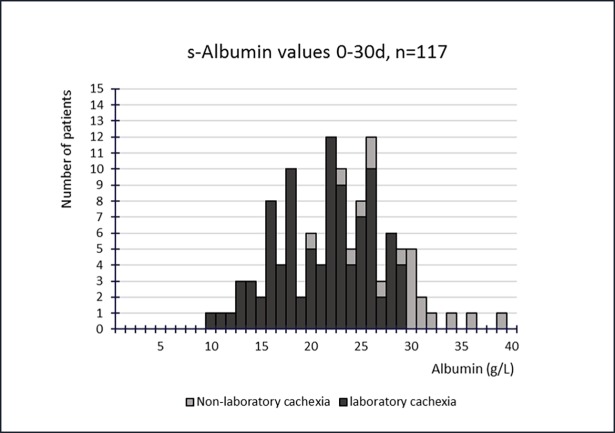
S-albumin values, 0-30d.S-albumin values within the 0-30d period for all patients with available measurements for both CRP and s-albumin within this period.